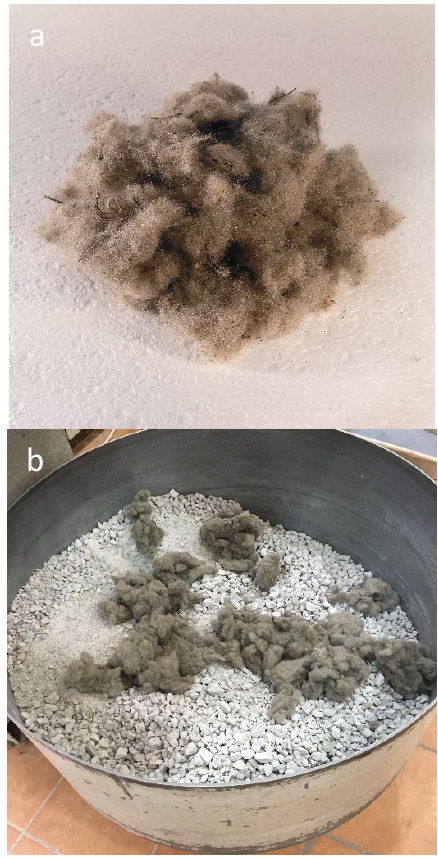
log. equivalent sieve opening, Figure 2. Aggregate grading curves.